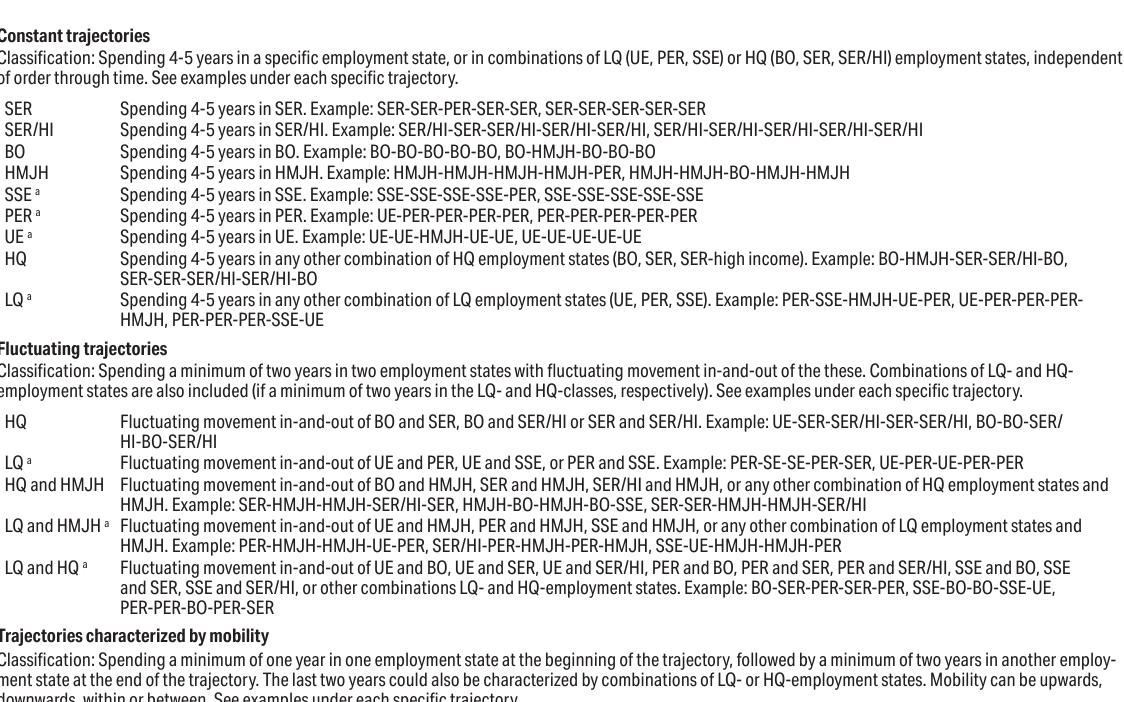
Table 1. Description of employment trajectories identified in the cohort. [UE=unemployment; PER=precarious employment relationship; SSE=solo self-employment; HMJH=hybrid multiple job-holding; BO= business ownership; SER= standard employment relationship; SER/HI=standard employ - ment relationship with high income; LQ=low quality; HQ=high